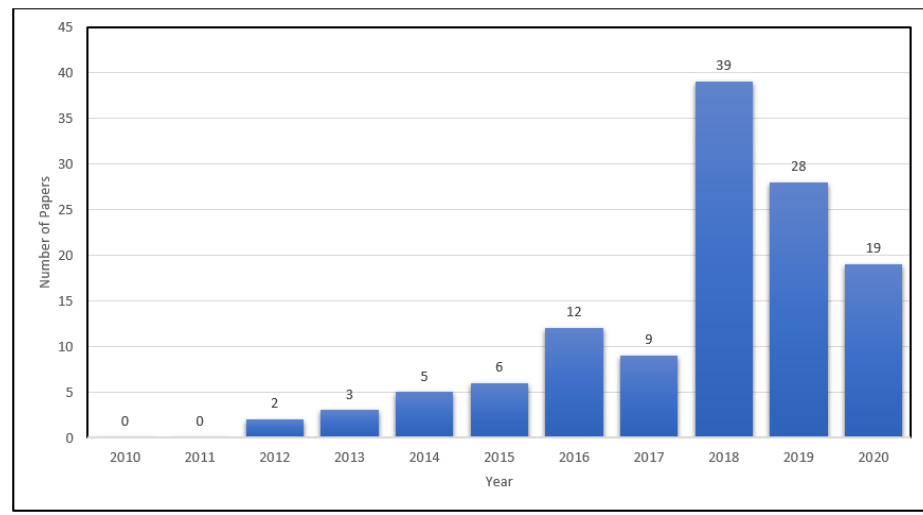
Figure 1. Number of Papers According to Year of Publication.